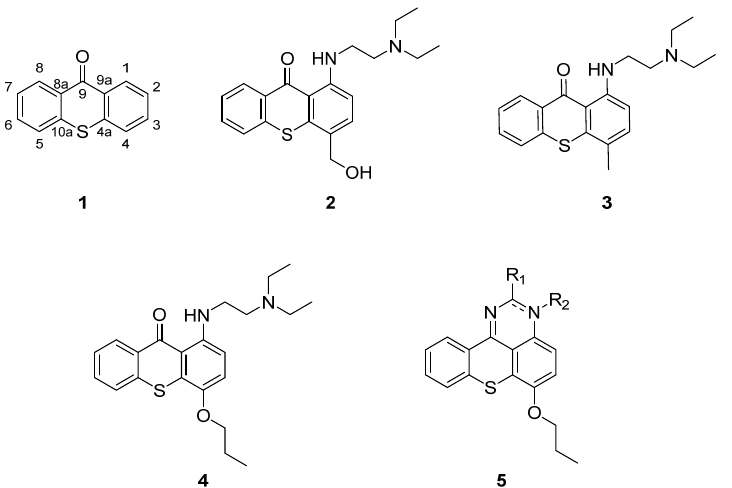
Figure 1. Structure of the thioxanthone scaffold ( 1 ), the anticancer thioxanthones hycanthone ( 2 ) and lucanthone ( 3 ), the dual tumor cell line growth/P-glycoprotein inhibitor ( 4 ) and the general structure of the compounds studied in this work ( 5 ).